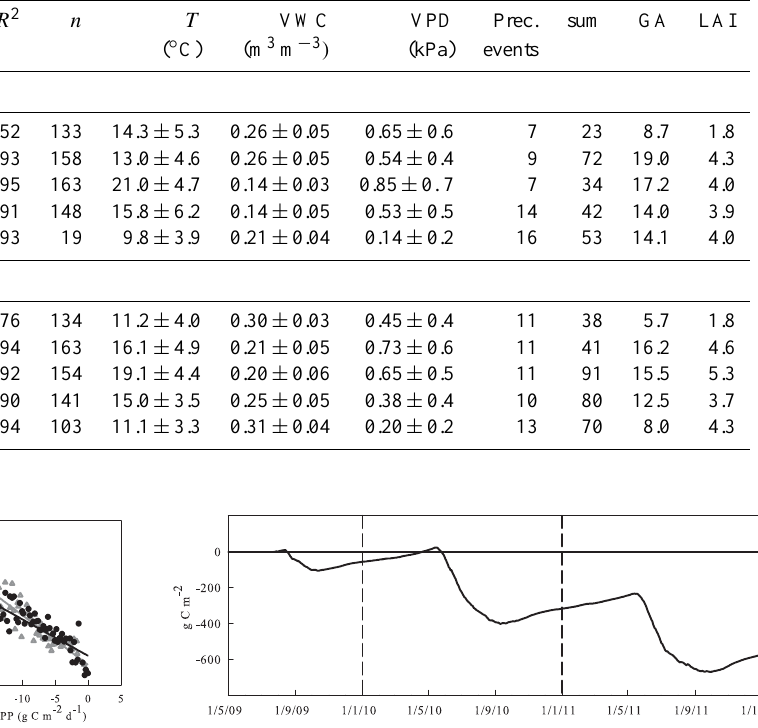
Figure 8. Cumulative NEE over the study period. Negative values Figure 7. Relationships between total ecosystem respiration (TER) indicate uptake of CO 2 and positive values emission to the atmo- and environmental variables. (a) TER (µmolm − 2 s − 1 ) and soil sphere. Horizontal solid black lines show the zero level and vertical temperature ( ◦ C) at 2.5cm depth (binned with steps of 0.5 ◦ C) dashed black lines mark beginning of the in May–September period fitted with an exponential nonlinear re- gression (TER = R 10 × Q (T s /T 10 ) , where R 10 and Q 10 are fit- 10 ted parameters). (b) Weekly averaged TER (gCm − 2 d − 1 ) and green area index (GA, m 3 m − 3 ) in May–October period fitted with linear regression. (c) Daily values of TER (gCm − 2 d − 1 ) and gross primary production (GPP, gCm − 2 d − 1 , binned with steps of 0.25gCm − 2 d − 1 ) in May–September period fitted with linear re- gression. Closed grey triangles are data for 2010 and closed black circles for 2011. Fit results are given in the text.